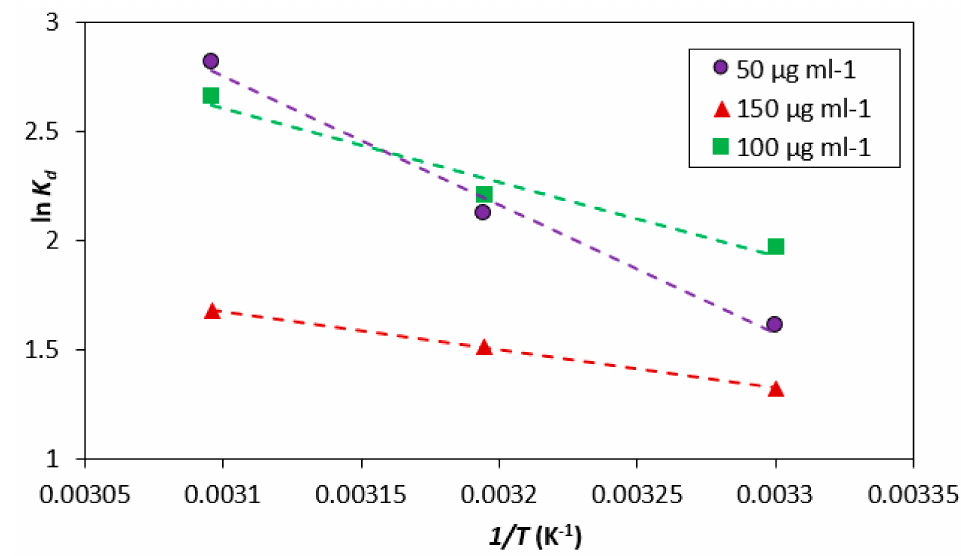
Figure 10. Graph signifying the enthalpy and free energy of